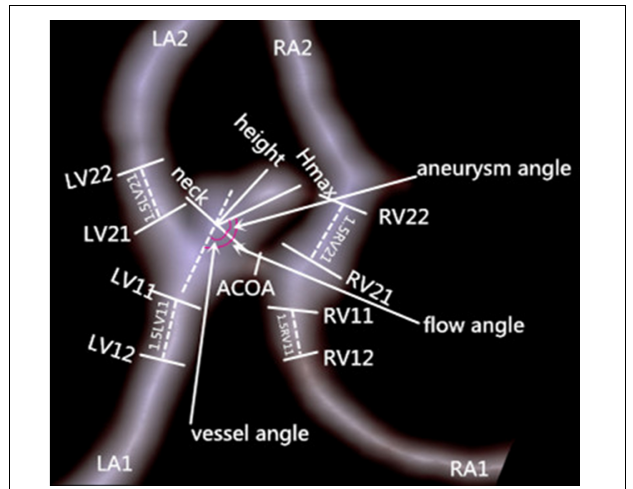
FIGURE 1 | Measurement of morphologic parameters. Left ventricle (LV)11 and LV12 represent cross-section diameters of the artery, left atrium (LA)1 proximal to aneurysm neck and at 1.5XLV11 away from aneurysm neck, respectively; vessel size of LA1 is calculated as (LV11+LV12)/2. Vessel sizes of LA2, right atrium (RA)1, and RA2 are similarly calculated. Hmax is aneurysm height.